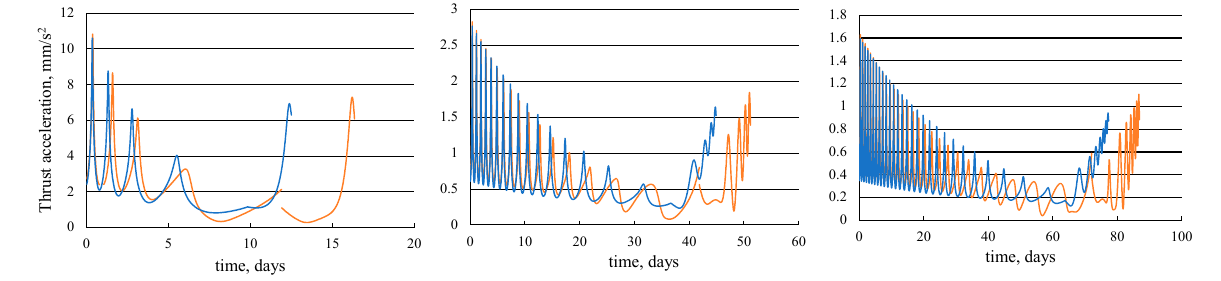
Figure 3. The time dependence of thrust acceleration for the transfer to the Moon. Figure 4 presents the time dependences of the adimensional values of costate variables to the vectors r and v on the 4-revolution LP-trajectory to the Moon. For the trajectory with an intermediate EM L 1 rendezvous (orange line), there is a discontinuity in all six costate variables, since two separate optimization problems for the geocentric and selenocentric segments of trajectory are being solved. In the case of the trajectory with an optimal junction of two segments (blue line), the dependences of the costate variables to the components of the velocity vector p v are continuous, but the costate variables to the components of the position vector p r have a discontinuity λ 1 · r + /r + at the junction point.